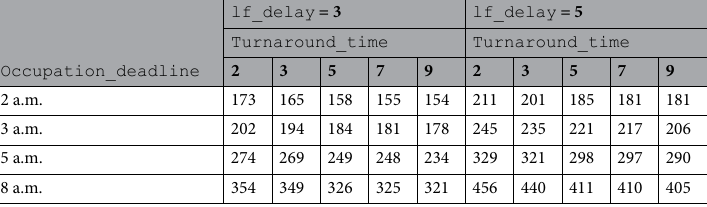
Table 3. Number of identified L/F events for the GB2 colony in 2008 with different values of the three